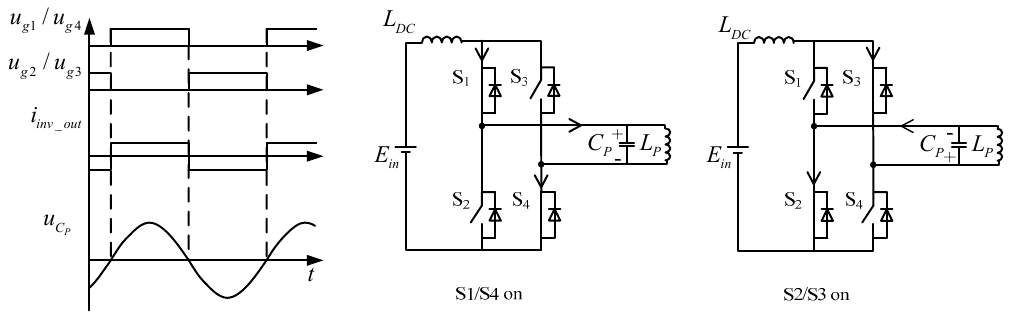
Figure 3. Waveform and circuit when f